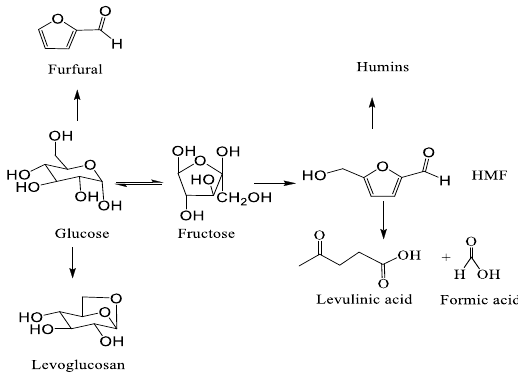
Figure 4. Reaction pathway of glucose. Table 2. Concentration of HMF in the vapor.